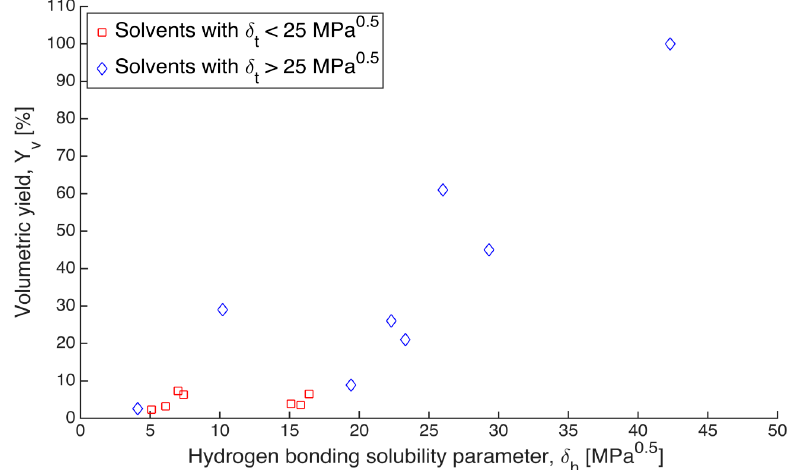
Figure 3. Relation between the volumetric yields ((cid:1851) the total solubility parameter ( δ t ) of the respective solvents. Blue points refer to solvents with total solubility parameter above 25 MPa 0.5 , and red points refer to solvents with total solubility parameter below 25 MPa 0.5 .